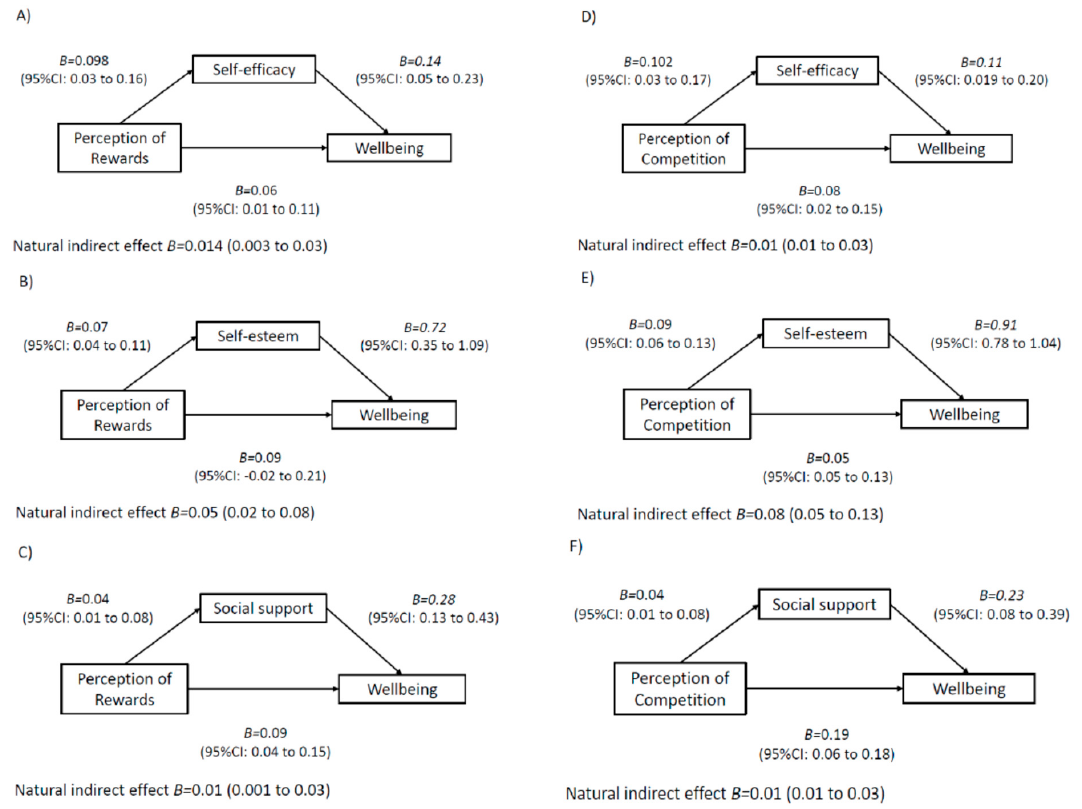
Figure 4. Mediation models of potential psychological mediators in the association between intervention components and wellbeing among girls. Note. Adjusted for age, ethnicity, language, school, BMI z-score and baseline values of change variables. CI, confidence interval. E-values estimates (in relative risk): Model A : E-value: 1.32, Model B : E-value: 1.19, Model C : E-value 1.33, Model D : 1.39, Model E : E-value 1.18, Model F : E-value 1.38.